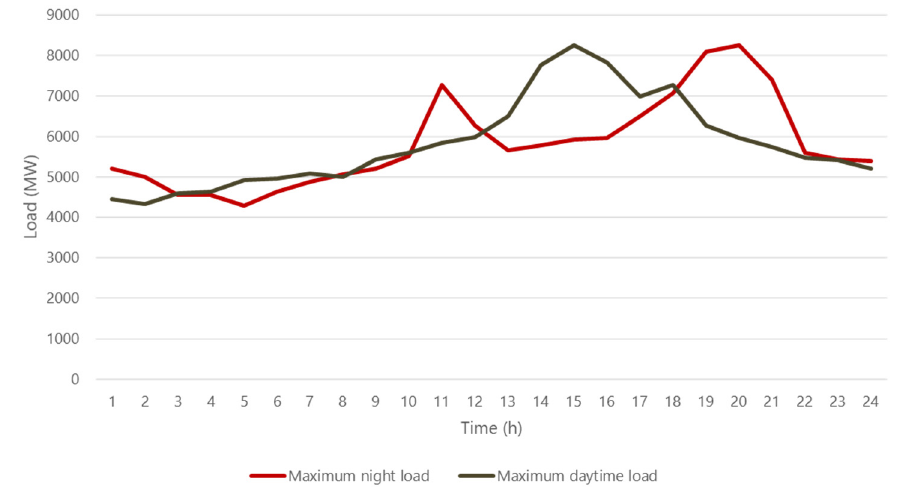
Figure 3. One-day load